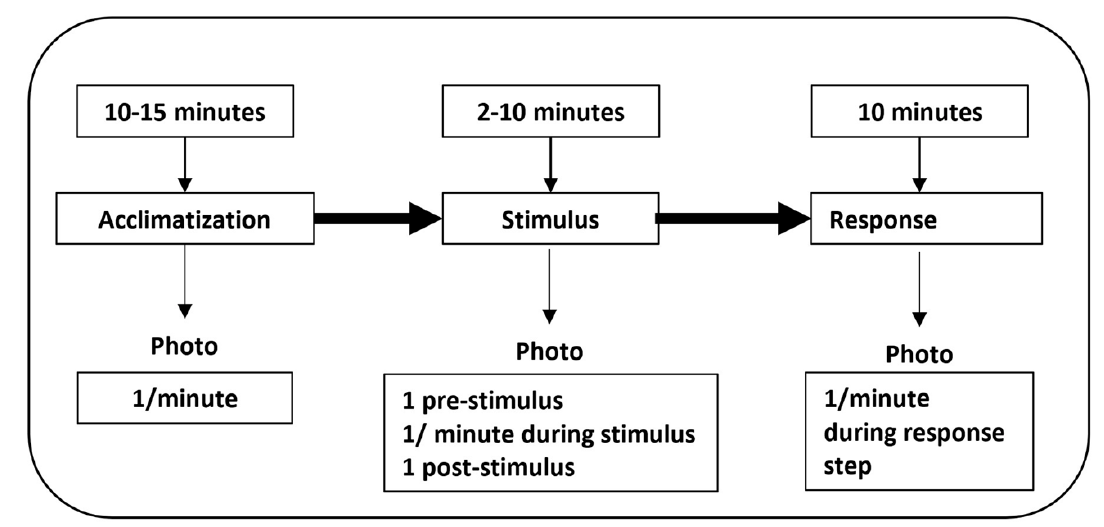
Figure 3. Workflow for data acquisition. During taking of thermographic images—protocol application.